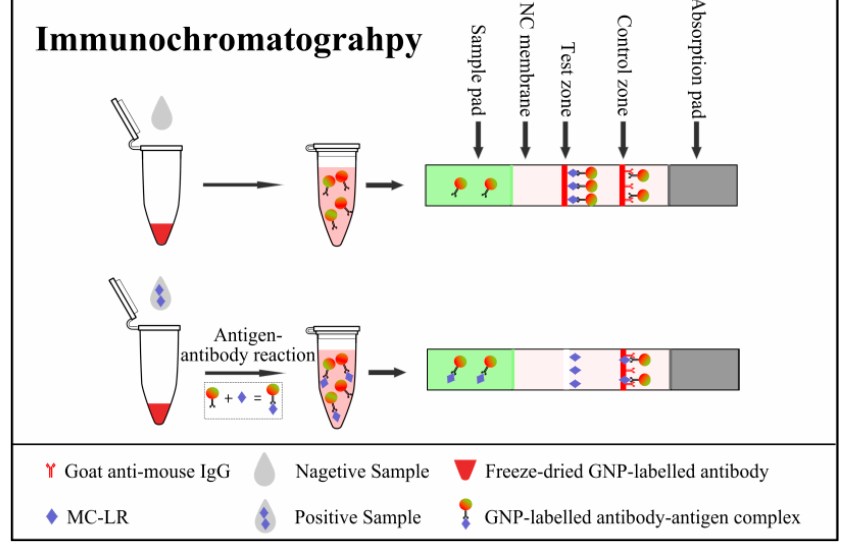
Figure 2. Schematic diagram of the immunochromatography for MC-LR detection.